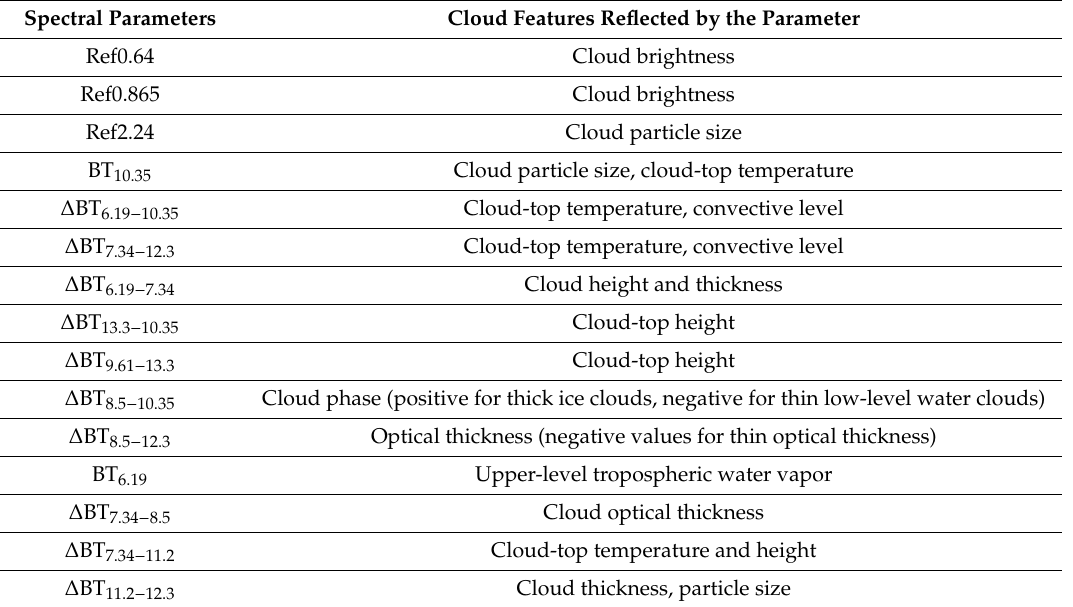
Table 2. Spectral parameters used in the models, with the subscript number being the central wavelength ( µ